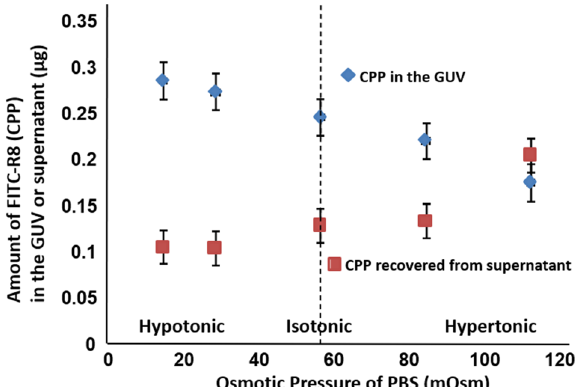
Figure 3. Effect of Osmotic pressure for the Cytolysis of FITC-R8 (CPP) into GUV made of the egg yolk phosphatidylcholine (EPC) (Lipid/peptide molr ratio (L/P) = 1000, 10 min, at 37 °C, n =